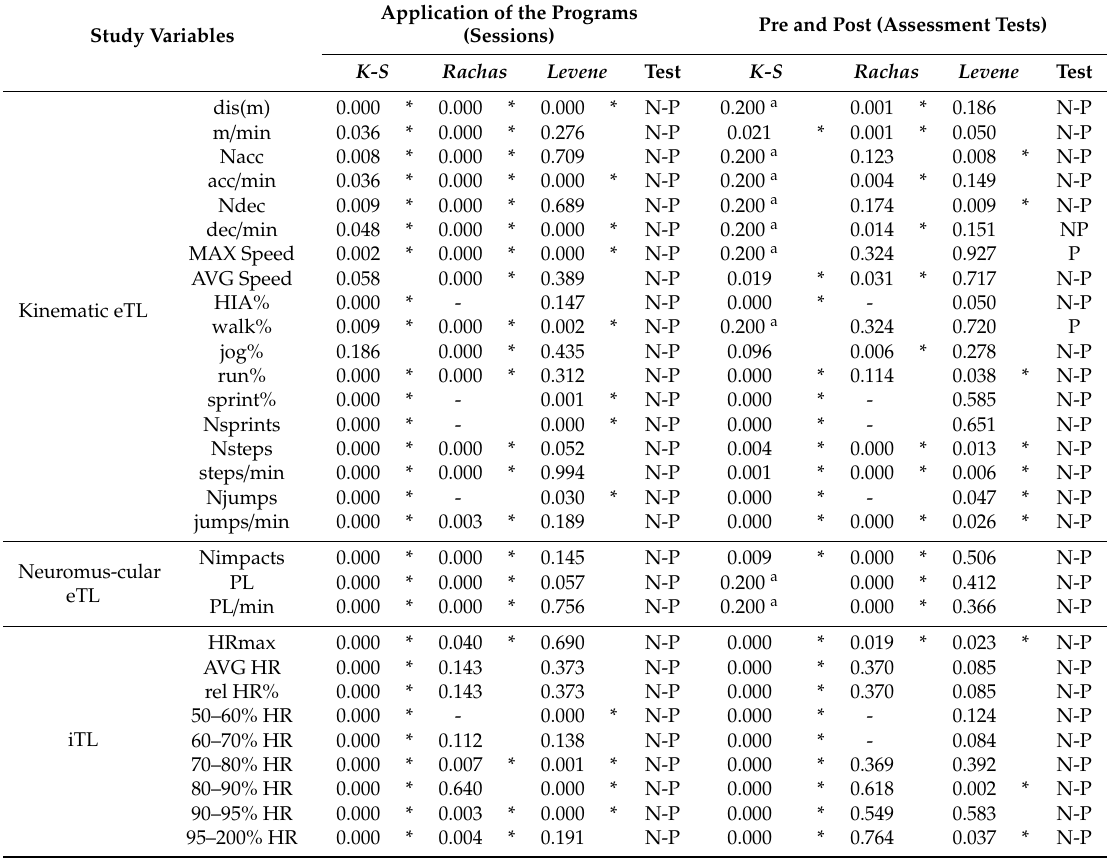
Table 1. Results of the statistical tests for the assumption of the following